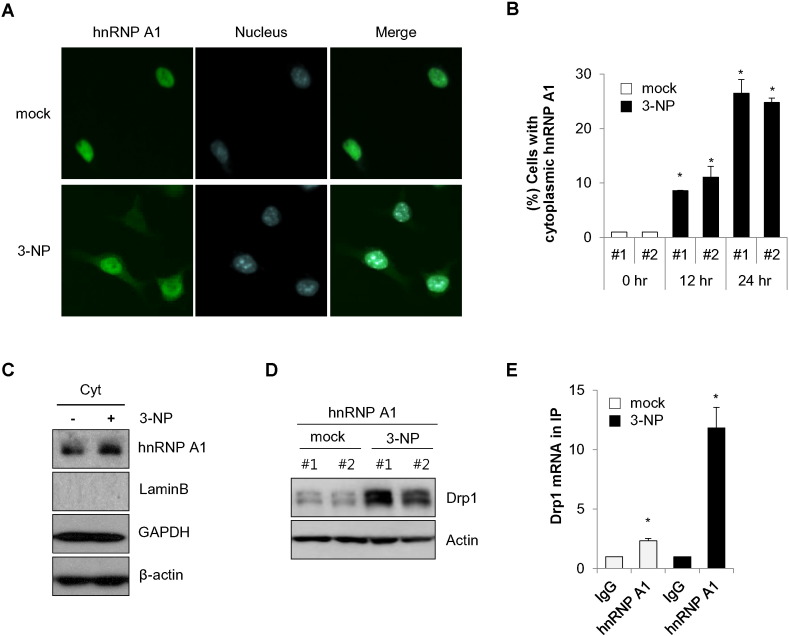
3-NP induces cytosolic translocalization of hnRNP A1 and enhances Drp1 expression.SK-N-MC/GFP-hnRNP A1 cells (#1 and #2) were incubated in the presence or absence of 3-NP (10 mM) for 16 h. (A) The cells were stained with a Hoechst dye for nuclear staining. Cytoplasmic translocation of hnRNP A1 was imaged by a fluorescence microscopy. (B) Cells showing cytoplasmic hnRNP A1 in the presence of 3-NP were counted with a fluorescence microscope. (C) Cytoplasmic RNP A1 was determined by cell fractionation and Western blotting with indicated antibodies. Both lamin B and GAPDH were used for controls. (D and E) SK-N-MC/hnRNP A1 cells (#1 and #2) exposed to 3-NP for 24 h were harvested and analyzed by Western blotting using Drp1 antibody (D). The cell lysates were subjected to RNP complex immunoprecipitation followed by RT-qPCR analysis to detect enriched Drp1 mRNA in hnRNP A1 immunoprecipitates (hnRNP A1). Data are represented as the mean ± SEM (n > 3, and *p < 0.05 value).